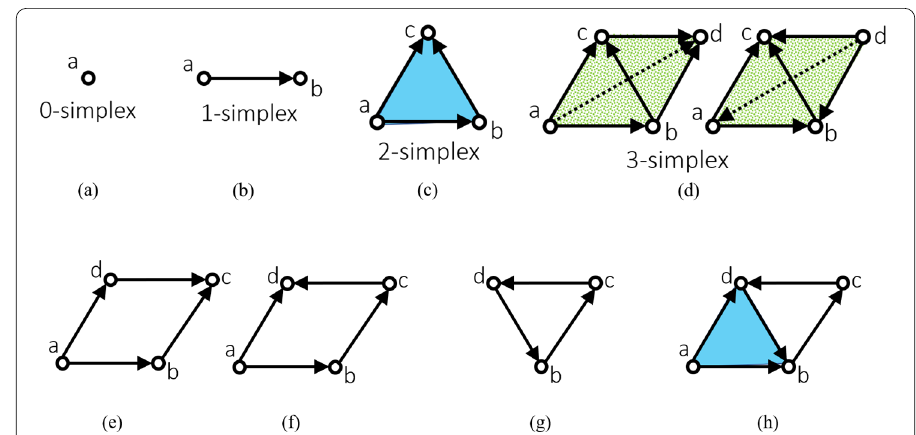
Figure 3 Examples and non-examples of Simplices. The order on the vertices is preserved by the corresponding simplex name: ( a ) a 0-simplex [ a ], ( b ) a 1-simplex [ a , b ], ( c ) a 2-simplex [ a , b , c ], ( d ) 3-simplices [ a , b , c , d ], and [ d , a , b , c ]. ( e ) and ( f ) Since not all vertices are connected, the set { a , b , c , d } does not form